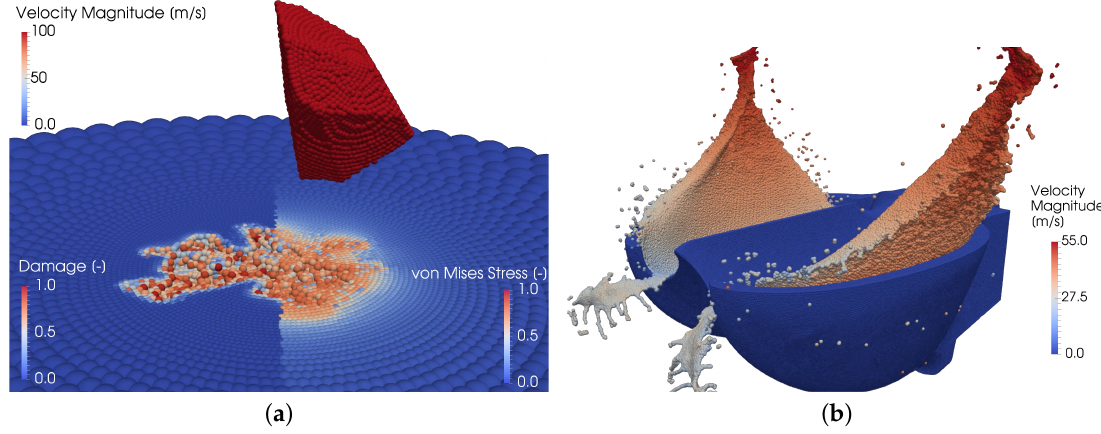
Figure 2. Finite volume particle method (FVPM) discretizations used in the multiscale model. ( a ) Microscale domain, where a sharp sediment is about to impact the solid. ( b ) Macroscale domain, where the water (with sediments too small to be seen) is being evacuated from the Pelton